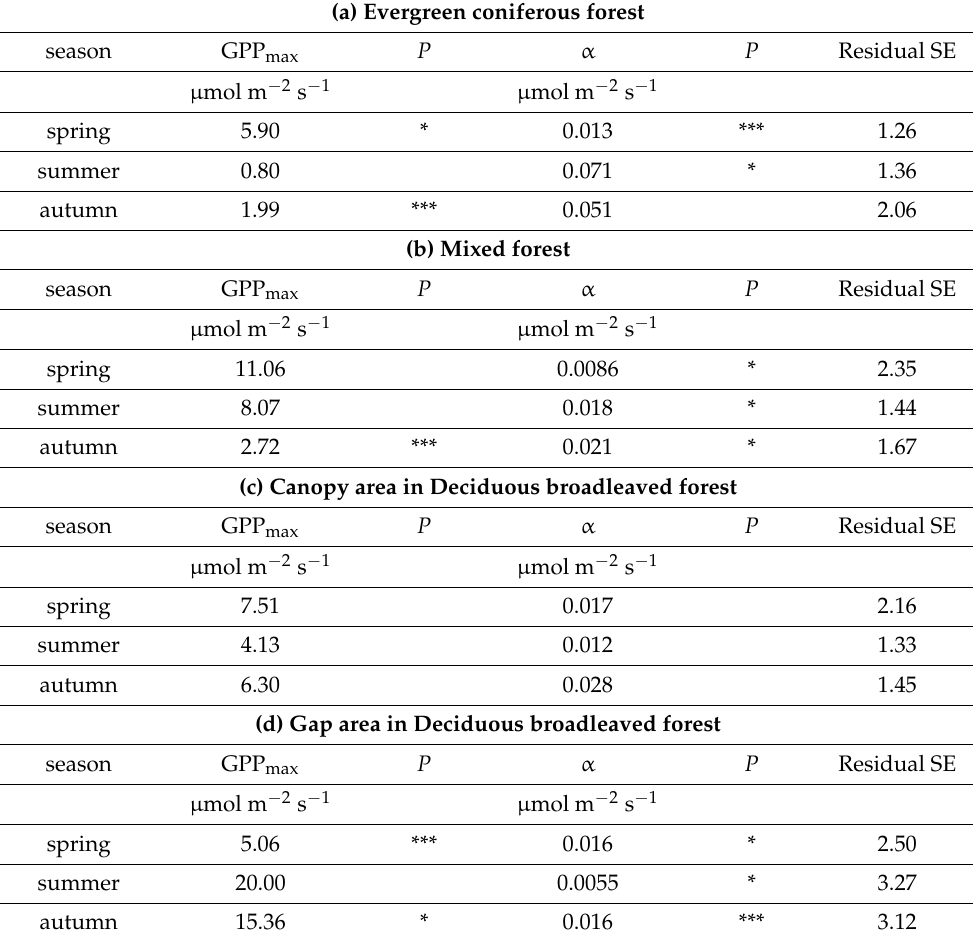
Figure 6. Light- Sasa community GPP per leaf area in the evergreen coniferous forest (ECF), mixed forest (MF), DBF canopy area, and deciduous broadleaved forest (DBF) gap area in each season. Table 2. Parameters of light– Sasa community GPP per leaf area curve in the four